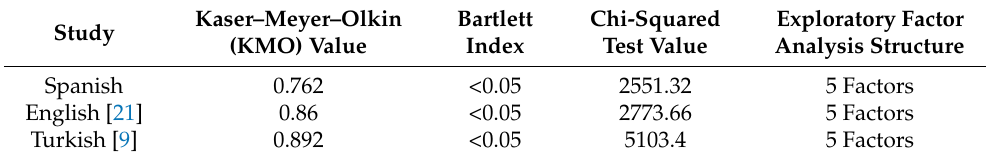
Table 6. Validity of FACIT-PAL